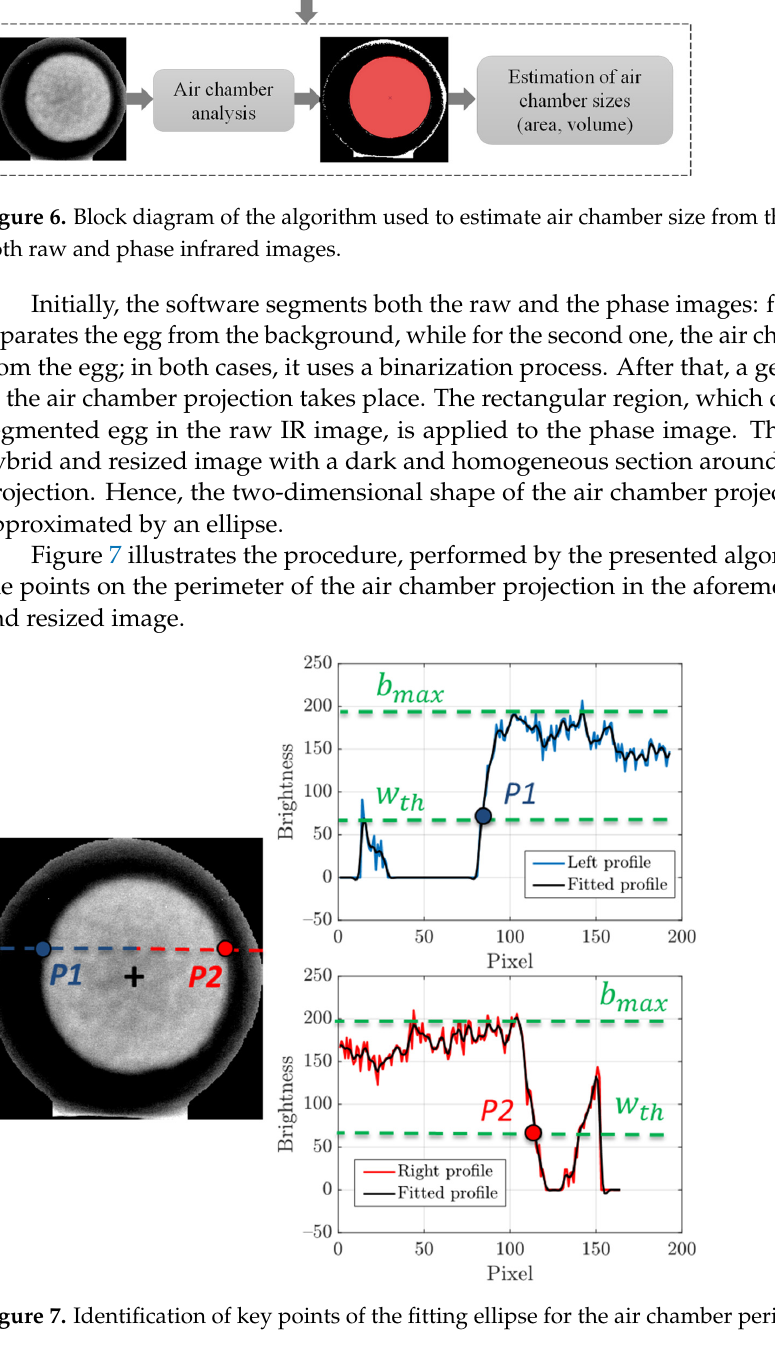
All pixel rows that cross the air chamber projection are fitted with a smoothing spline